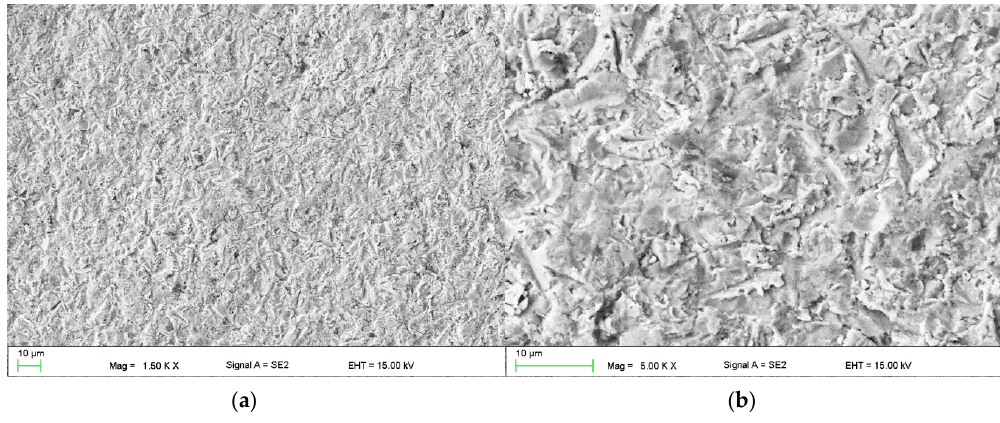
Figure 10. Coatings surface after erosion test: ( a ) lower magnification (1500 × ) and ( b ) higher magnification (5000 ×